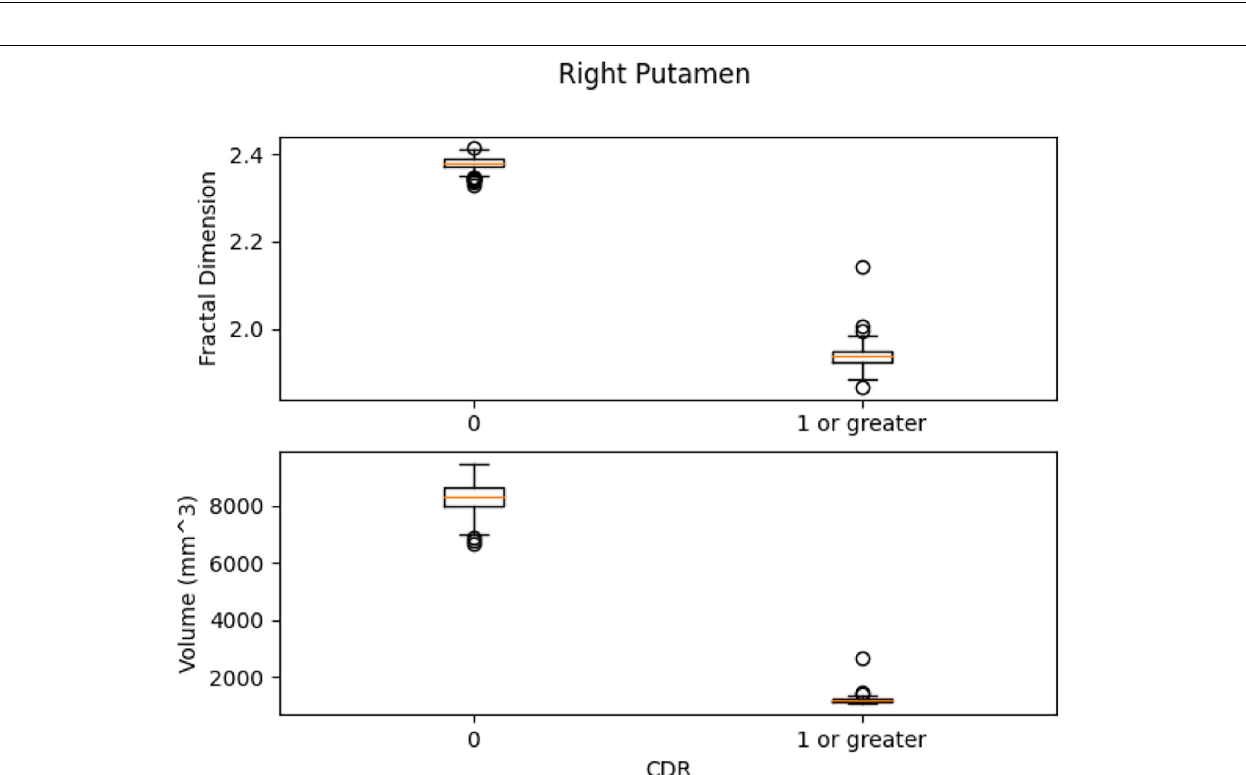
FIGURE 18 | The box plots for Right